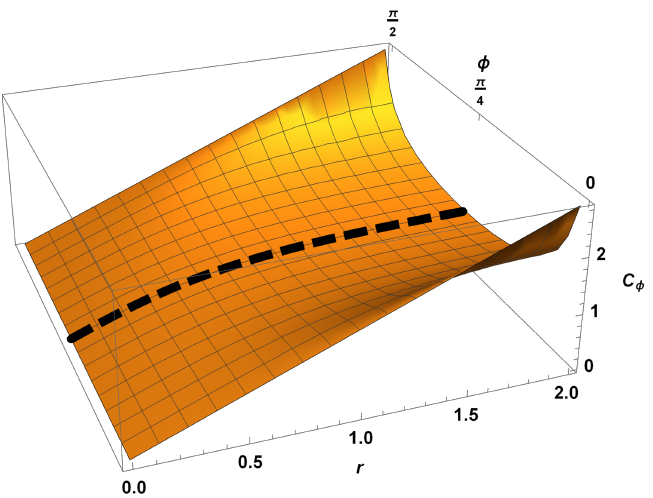
Figure 1. Complexity (2.16) of the purified thermal state as a squeezed state, as a function of the squeezing parameter r and the squeezing angle φ . The dashed line indicates the minimum of the complexity at φ = π/ 4 . The complexity saturates at large r (corresponding to high temperature) for generic φ as in (2.19), but grows linearly with the squeezing r for the angles φ = 0 , π/ 2